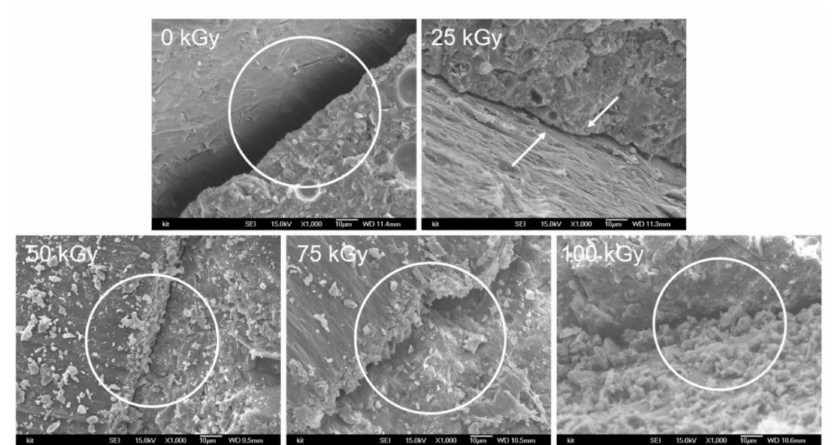
Figure 13. SEM images of